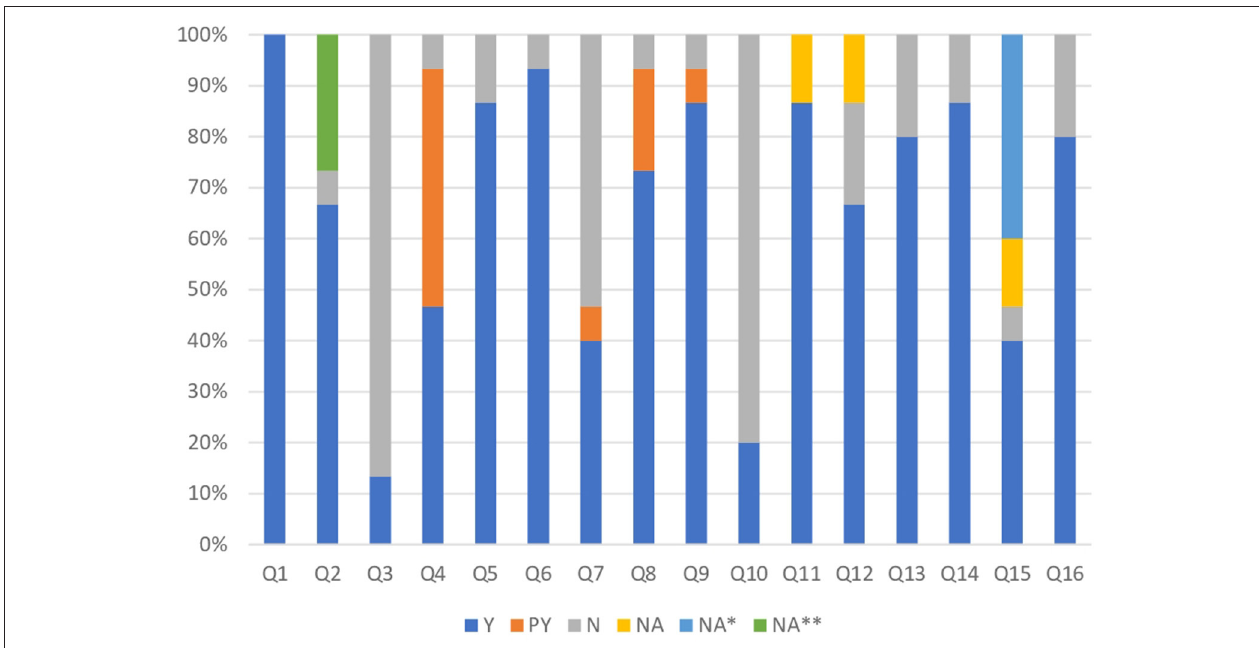
FIGURE 3 | Comparison of quality assessment of included reviews using AMSTAR 2 criteria. Y, yes; PY, partial yes; N, no; NA, not applicable; NA*, not applicable because there were 10 or fewer studies per outcome; NA**, the systematic review protocol records base PROSPERO was available virtually in February